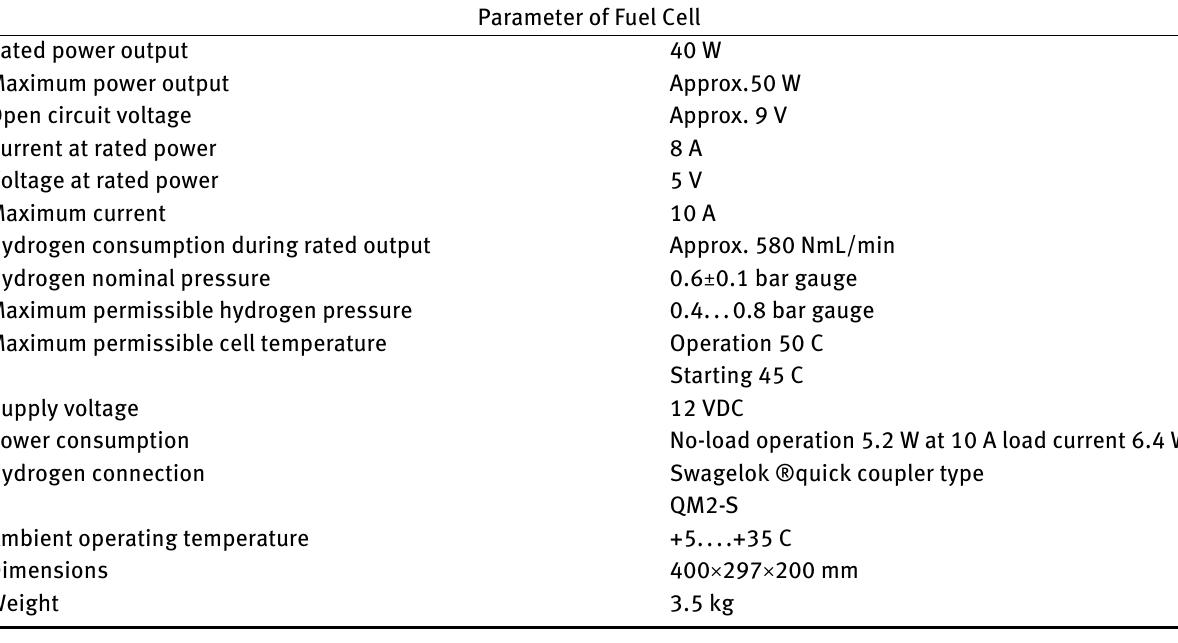
Table 2: Fuel cell parameters